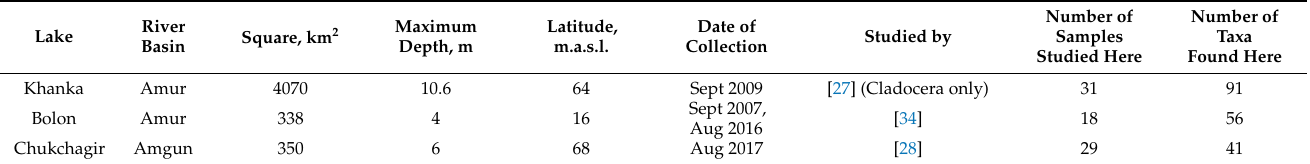
Table 1. The explored water bodies and the number of samples analyzed in this